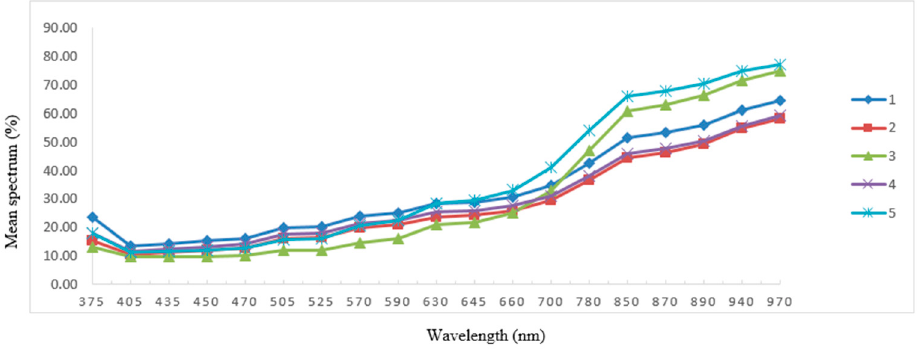
Figure 3. Mean spectrum (percentage) of 19 wavelengths (nm) in five damage classes (1–5) of sugar beet.